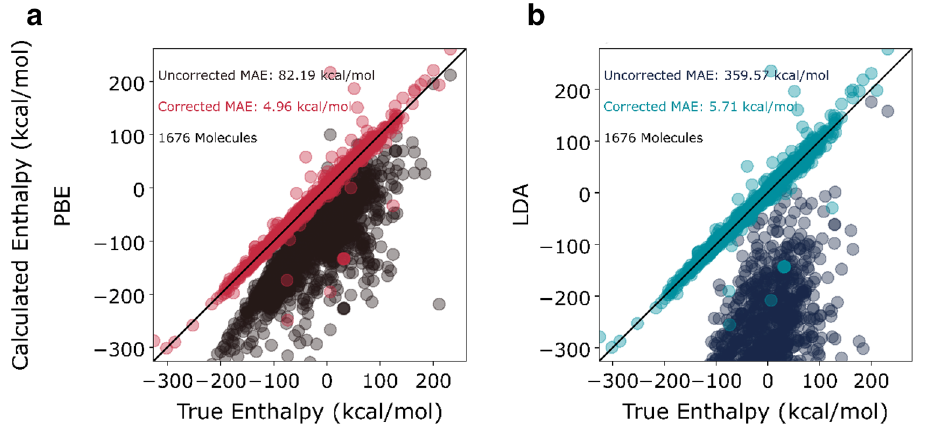
Figure 6. Performance of the surrogate LASSO error model in correcting enthalpies using the ( a ) PBE and ( b ) LDA for the entire